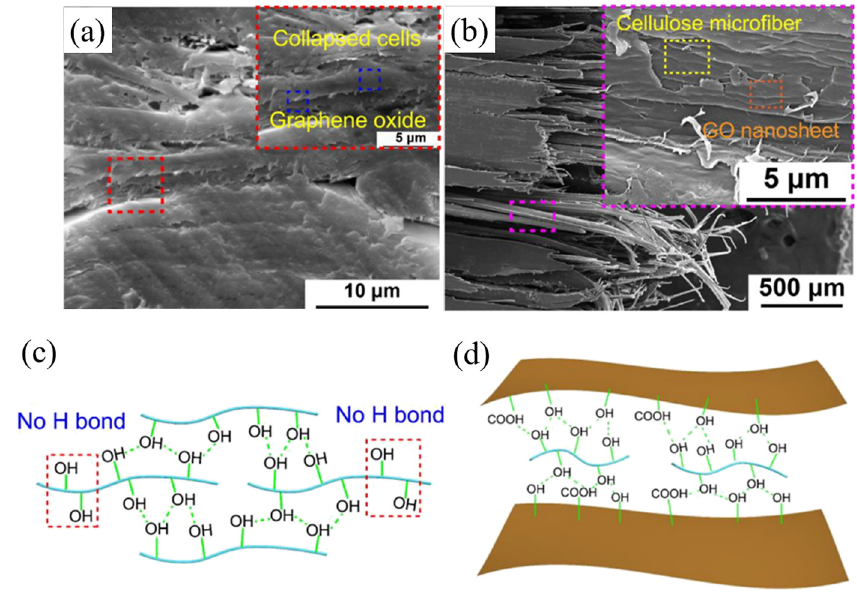
Figure 6: ( a ) Cross section of GO/bamboo [ 138 ] , ( b ) fracture surface of GO/bamboo [ 138 ] , ( c ) the hydrogen bonding in densi fi ed deligni fi ed - bamboo [ 138 ] , and ( d ) GO/bamboo composite [ 138 ]